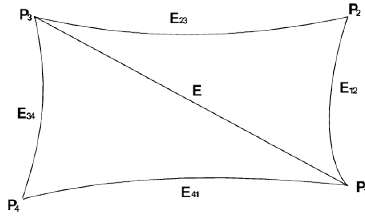
Figure 1. The quadrilateral Q E associated to edge E